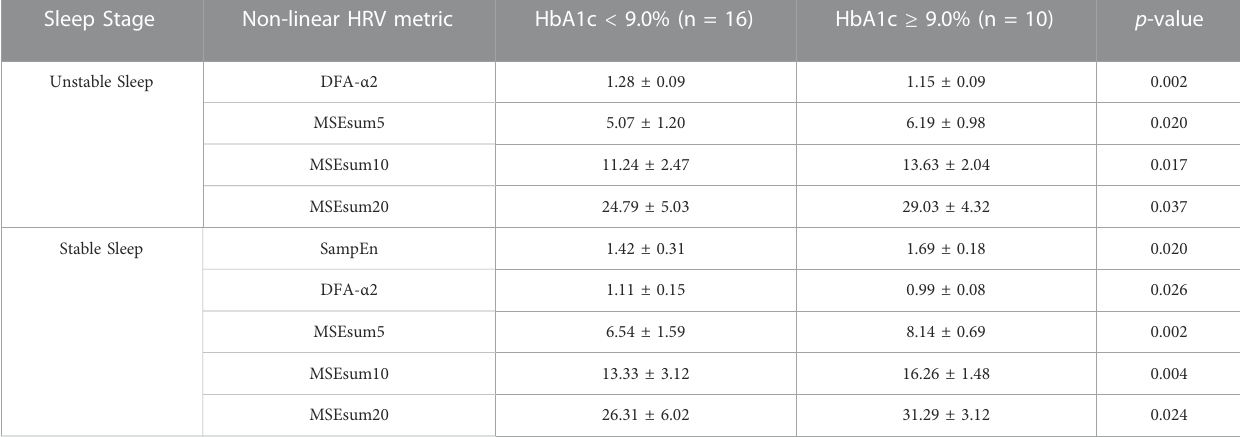
TABLE 8 Difference in non-linear HRV metrics between the group had poor control of diabetes (HbA1c ≥ 9.0%) or did not (HbA1c < 9.0%). Data are presented as mean ±